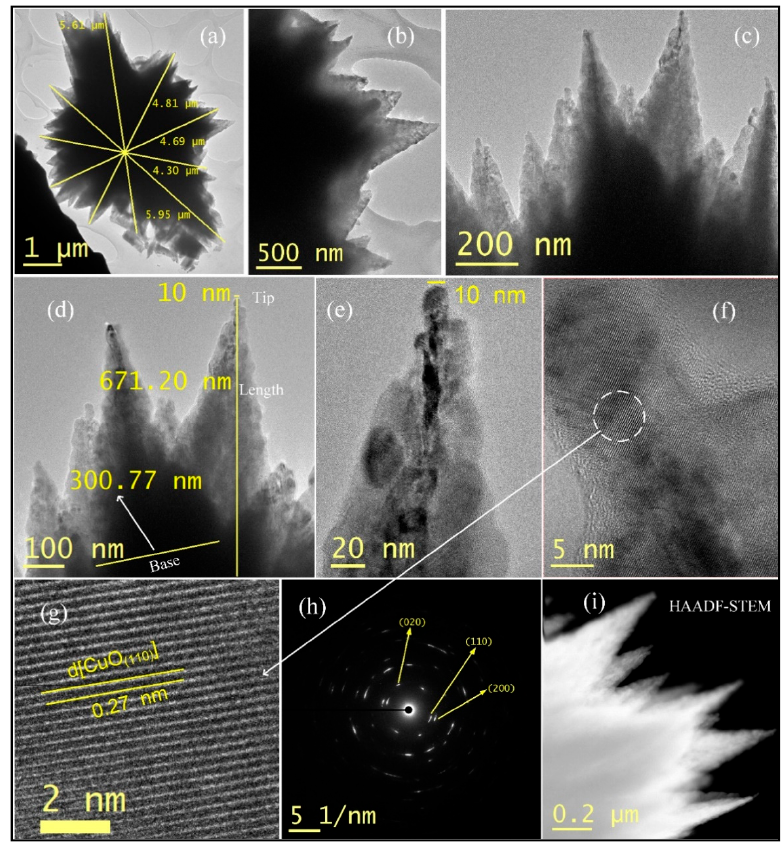
Figure 4. High-resolution TEM analysis of single copper oxide nanoflower. ( a – f ) TEM and HR-TEM images from low magnification to high magnification; ( g ) d-spacing; ( h ) SAED analysis; ( i ) HAADF-